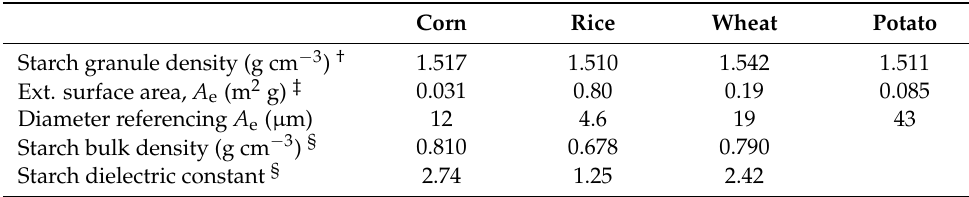
Table 2. Corn, rice, wheat and potato starch properties.